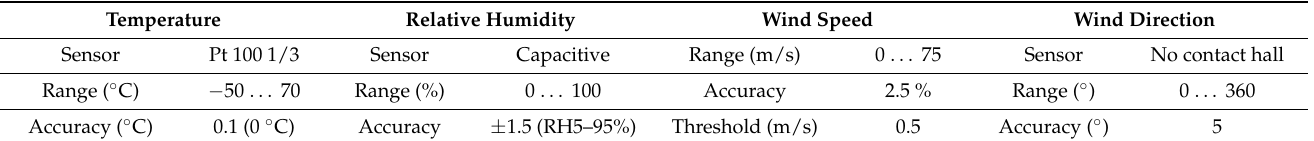
Table 2. Sensors